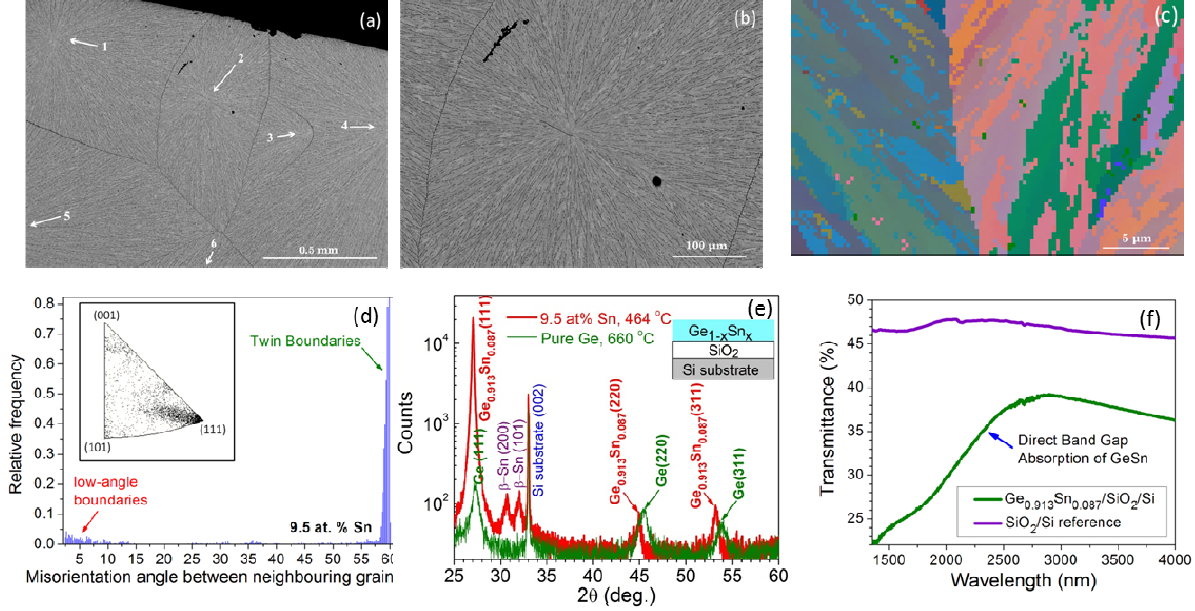
Sn thin film crystallized from 0.913 0.087